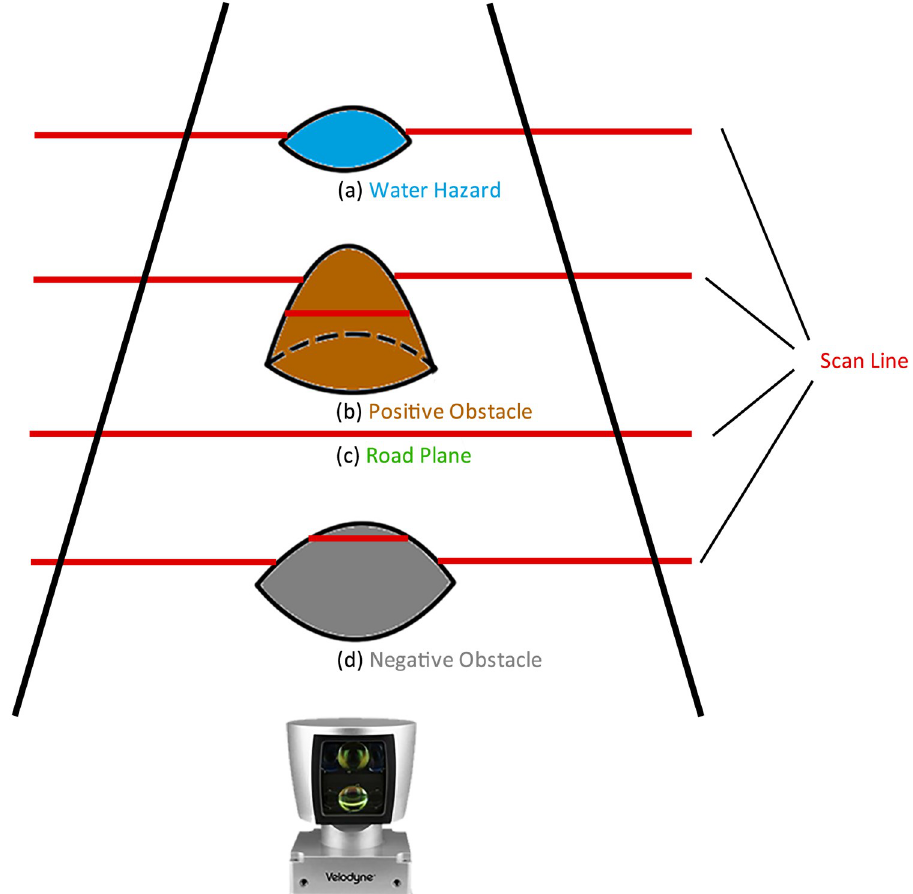
Fig 4. Different types of obstacles detected on